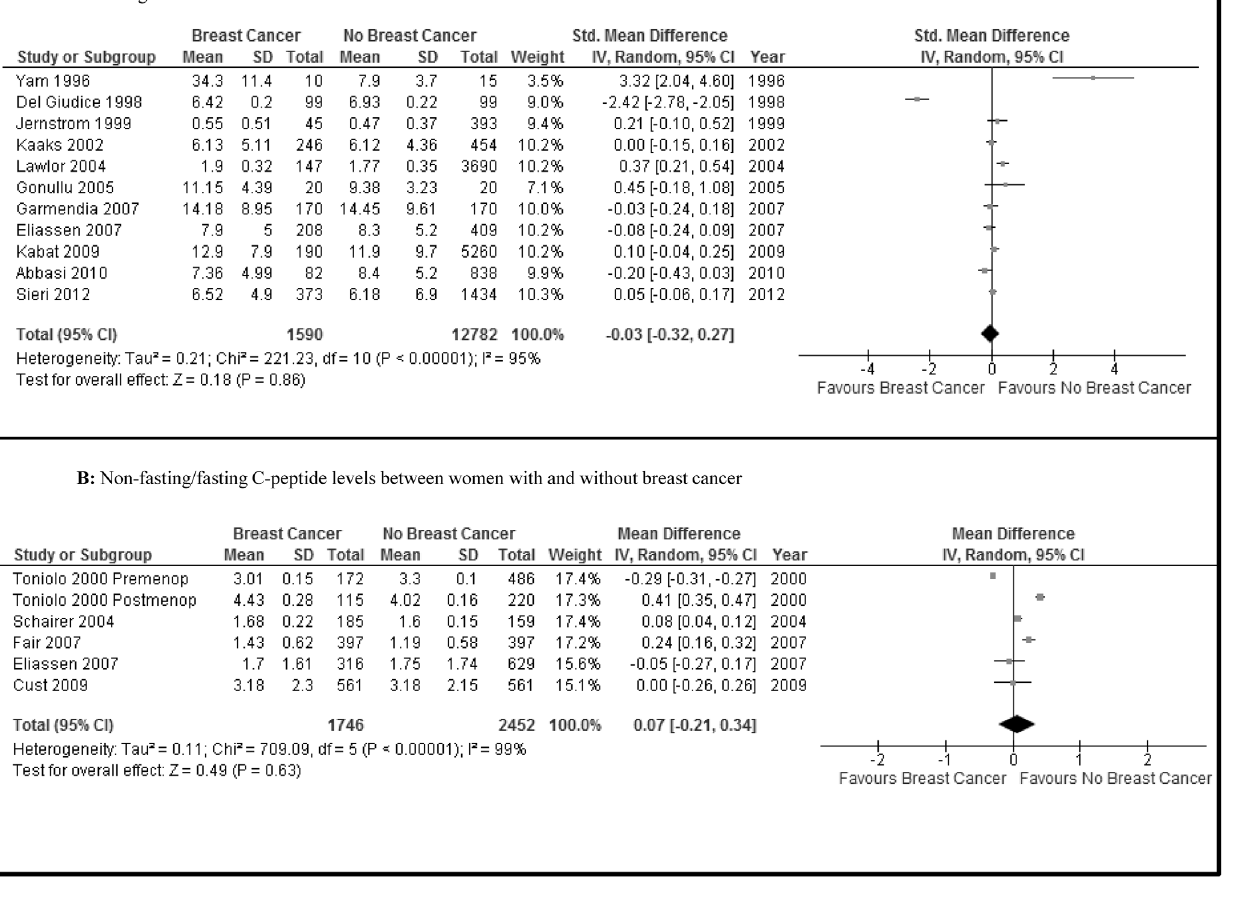
Figure 2. Forest plot of observational studies comparing women with and without breast cancer for (A) Fasting insulin levels and (B) Non-fasting/fasting C-peptide levels. (IV, Random = Inverse variance, Random effects model.)